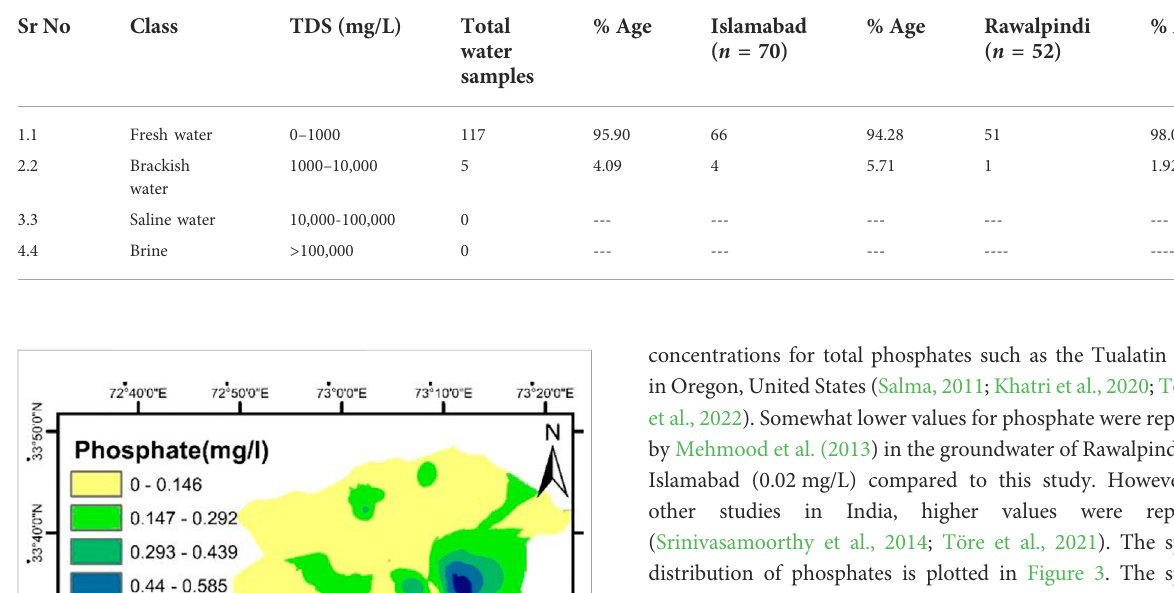
TABLE 3 Water quality assessment based on total dissolved solids (TDS) (mg/L) (Todd, 1980) n = 122.